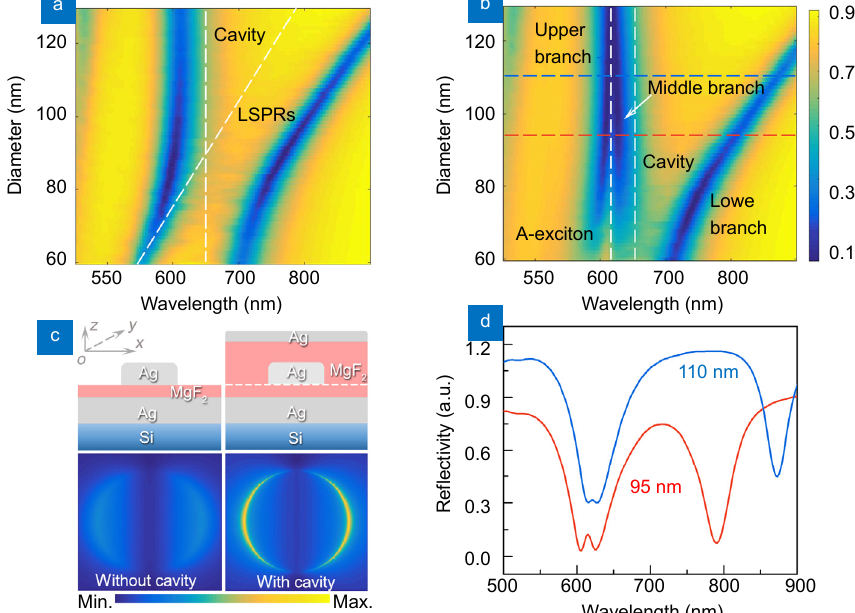
Fig. 3 | FDTD simulation results. ( a ) Simulated reflectivity spectra of Ag nanodisk embedded in an optical microcavity. White dashed lines rep- resent the resonance wavelength of the empty microcavity (~650 nm). ( b ) Normalized reflectivity spectra of Ag-WS 2 heterostructure with the opti- cal microcavity. Three different energy branches are emerged because of the strong coupling among the optical microcavity, surface plasmons and A-exciton of WS 2 monolayers. ( c ) Electric field intensity distributions ( E / E in ) 2 on the xoy plane of Ag nanodisk with and without microcavity. ( d ) Expanded views of the simulated reflectivity spectral feature for disk size of 110 nm (top line) and 95 nm (bottom line) in (b),